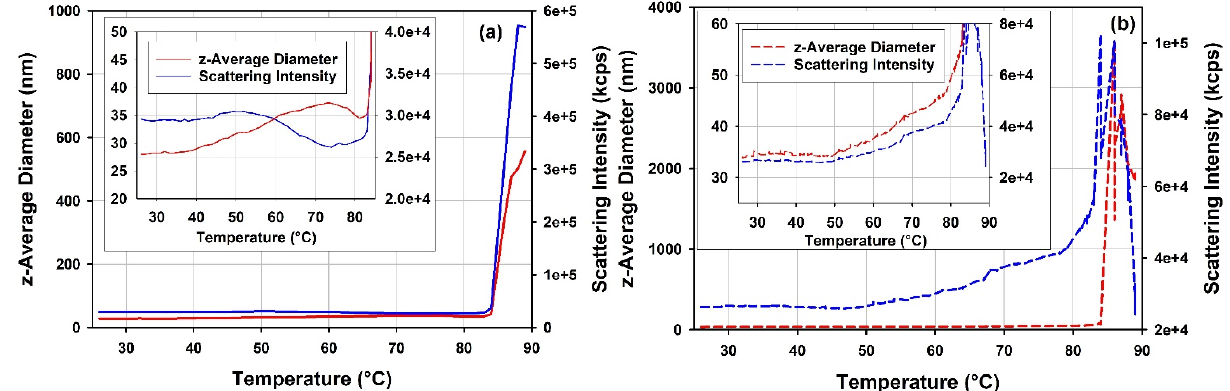
Figure 12. DLS thermal ramp data as overlays of the scattering intensities, DRC in kilocounts per second and z—average hydrodynamic diameter in nanometers as a function of temperature for ( a ) the full rAAV5 and ( b ) for the empty rAAV5.